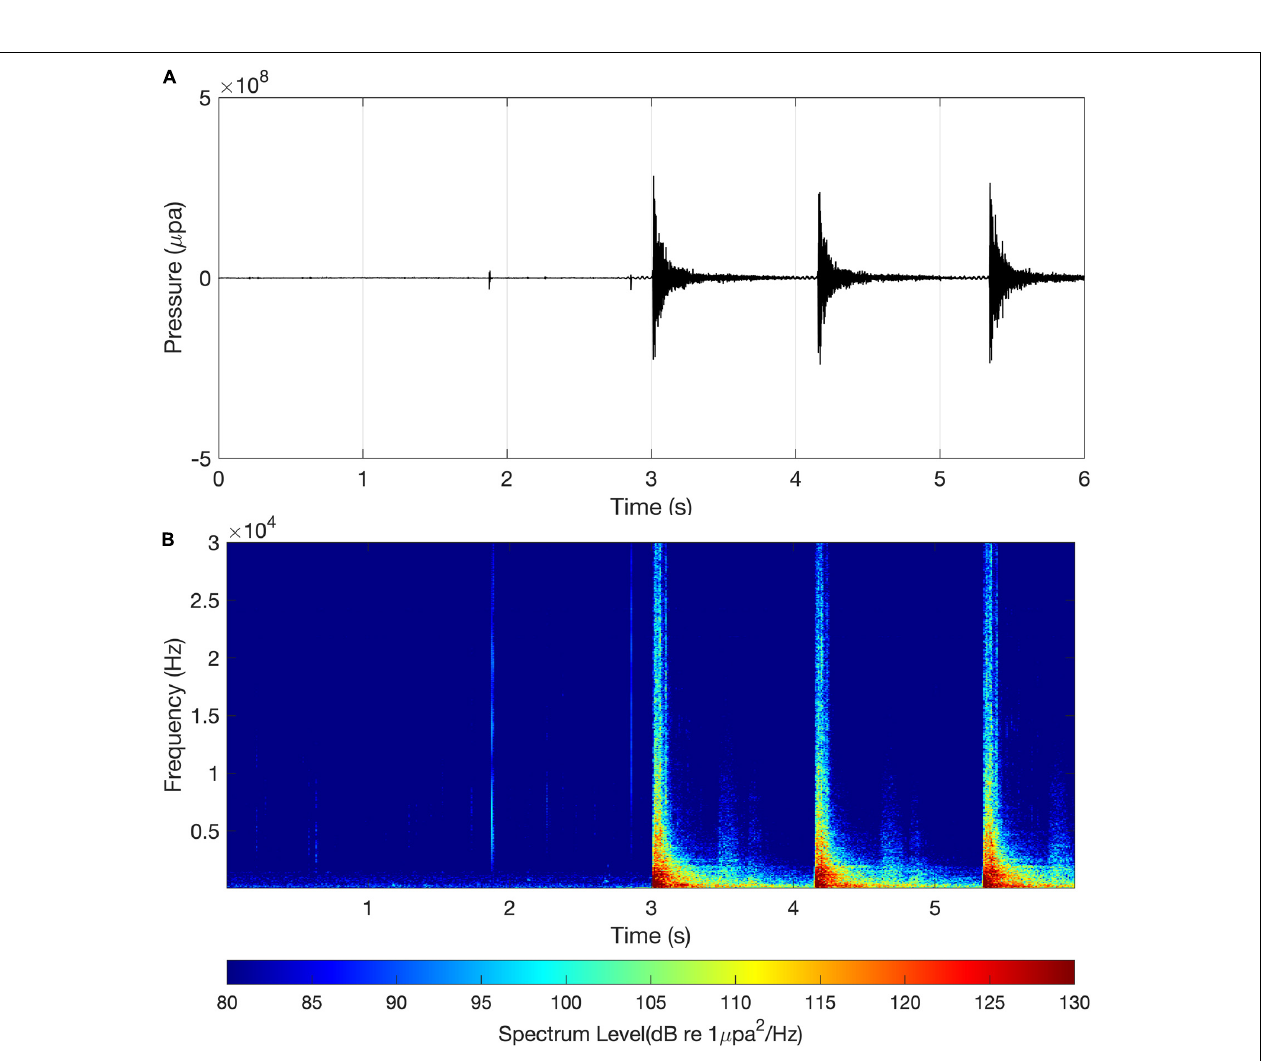
FIGURE 3 | (A) Time series and (B) the spectrogram of impact pile driving noise measured ∼ 639 m from the pile and a depth of 3 m above the seafloor.